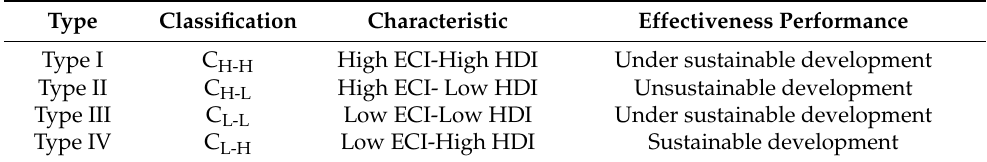
Table 5. The evaluation classification for effectiveness assessment of EWP.